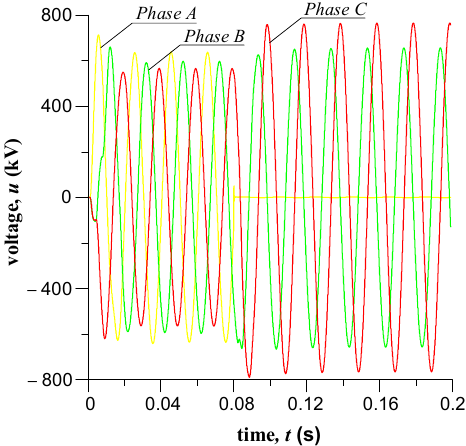
Figure 12. Phase voltage waveforms at the line’s end. However, as a result of the short circuit fault, the voltage amplitude of phase A decreased to zero, for phase B, it increased to 650 kV, and for phase C, it increased to 780 kV. Figure 13 contains a temporal–spatial waveform of phase A current in the time range t ∈ (0; 0.02) s.